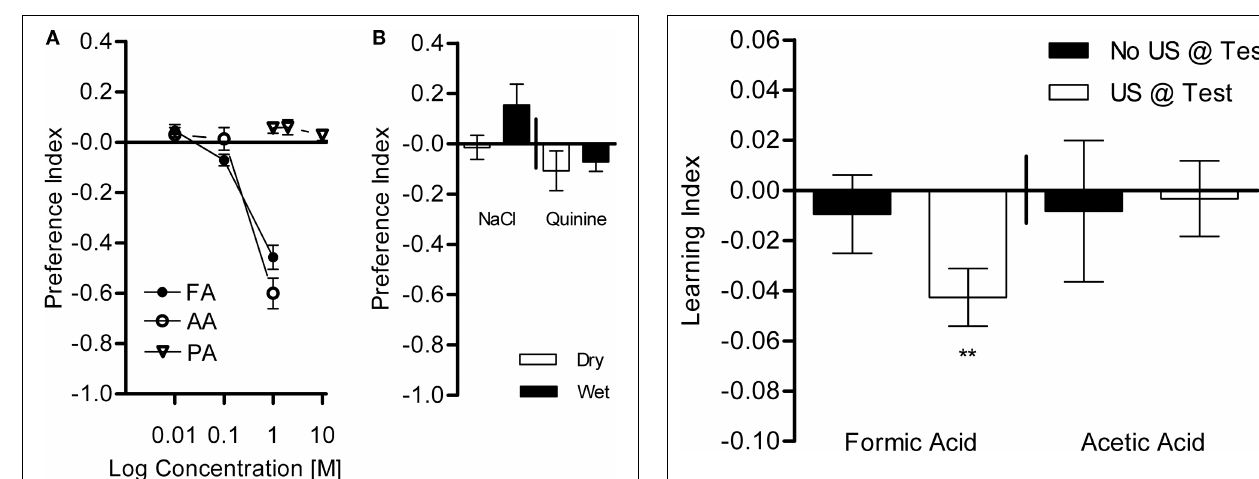
FIGURE 9 | Avoidance of diverse chemical substances. Choices between different chemical solutions and the control (water) were given to naïve fl ies. (A) Acid avoidance. Flies were tested with formic acid (FA), acetic acid (AA) at 0.01–1 M, and phosphoric acid (PA) at 1–10 M. Strong avoidance was found for FA and AA at 1 M [one-sample t -test, AA 1 M: t 1 M: t = 15.13, P < 0.001], whereas moderate avoidance, if at all, was (7) observed at lower concentrations [one-sample t -test, AA 0.01 M: t